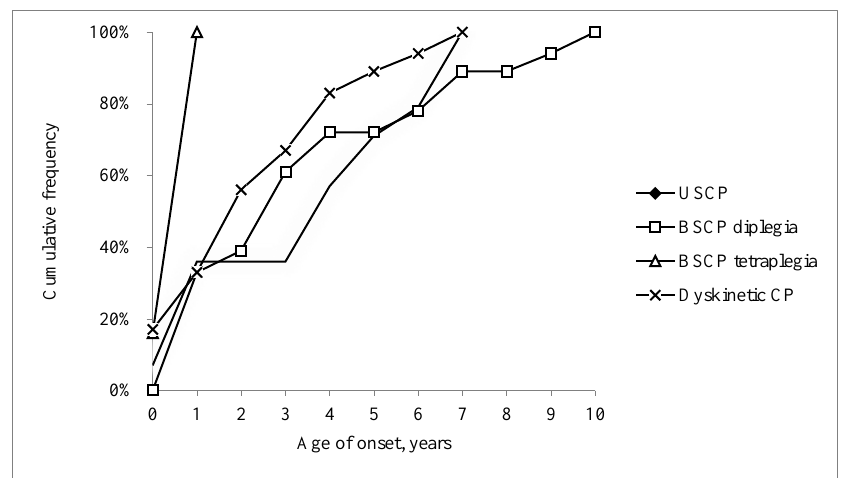
Figure 1. Cumulative frequency of epilepsy by age of onset (in years) in 59 children with epilepsy and unilateral spastic cerebral palsy (USCP), bilateral spastic cerebral palsy (BSCP; divided into diplegia and tetraplegia) and dyskinetic cerebral palsy. Table 2. Characteristics of epilepsy in 59 children with cerebral palsy